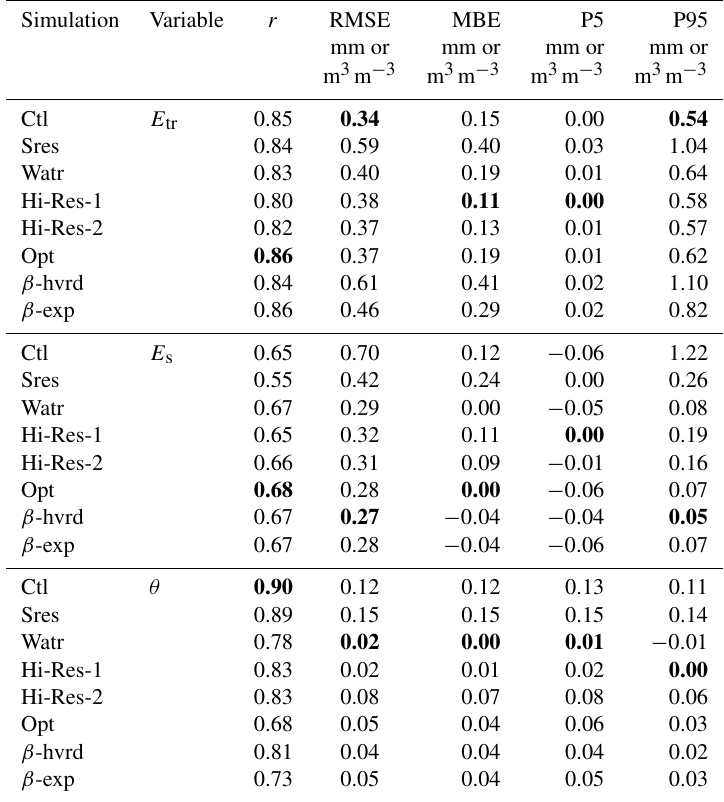
Table 2. Performance metrics for the different experiments. Bold numbers are the best value among these experiments.